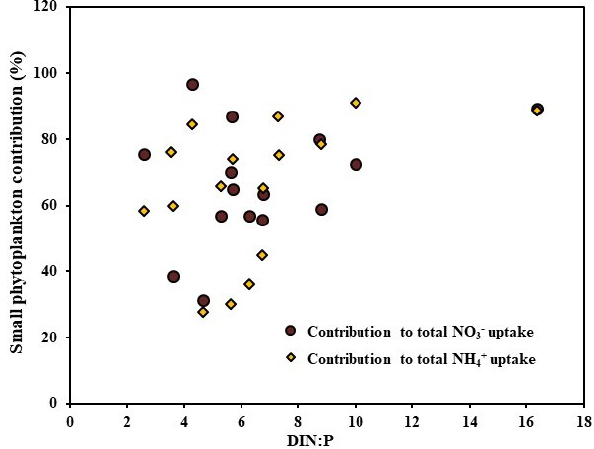
Figure 5. The relationship of the contribution of small phytoplank- ton towards the total NO −